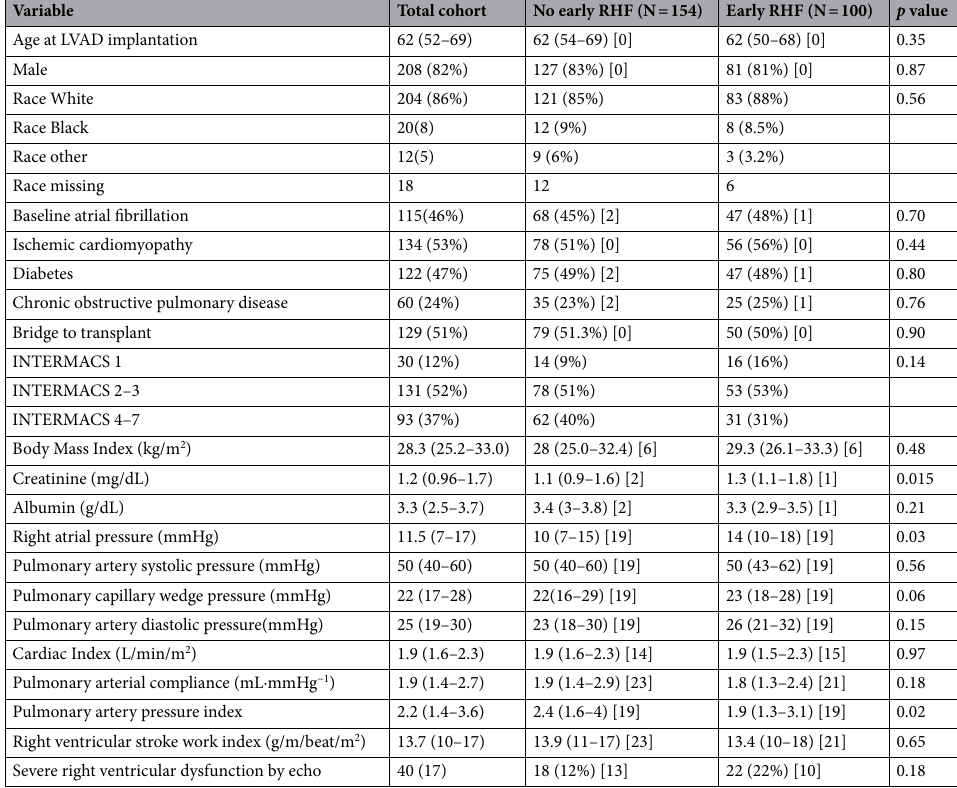
Table 1. Baseline characteristics of the cohort by presence or absence of early right heart failure by the. Continuous variables are described with median (IQR) [N missing]. Binary variables are described with N (%) [N missing].